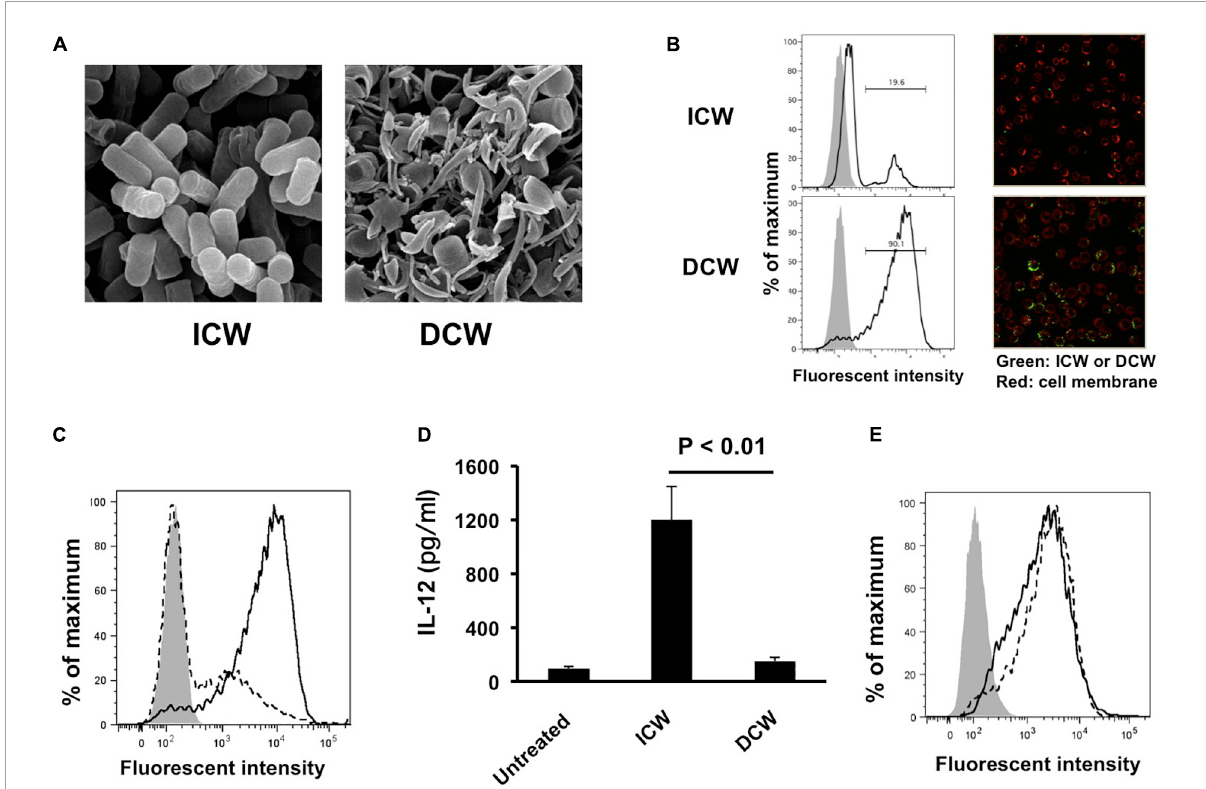
FIGURE9 Effects of disruption of overall shapes of ICWs on immunomodulatory abilities of ICWs. (A) Scanning electron microscopy of ICWs and DCWs of L. plantarum TUA 5099L. (B) Uptake of ICWs or DCWs. J774.1 cells were incubated with fluorescein-labeled ICWs or disrupted ICWs (DCWs) of L. plantarum TUA 5099 for 30 min and fluorescent signals in the cells were analyzed. Gray and open histograms indicate untreated and fluorescein-labeled cell walls treated cells, respectively. Representative images under florescent microscopy were also shown. (C) Reduction of uptake of DCWs by HF treatment. J774.1 cells were incubated with fluorescein-labeled DCWs (solid line) or HF-treated DCWs (dashed line) for 30 min and fluorescent signals in the cells were analyzed. Gray histograms indicate cells without DCW treatment. (D) Elicitation of IL-12 secretion from macrophages. J774.1 cells were cultured with ICWs (10 µ g/ml) or DCWs (100 µ g/ml) for 24 h and IL-12 secreted in culture supernatants was determined. Each bar is the mean ± SE for three independent experiments. (E) Effect of cytochalasin D on uptake of DCWs. J774.1 cells were treated with cytochalasin D in complete RPMI1640 containing 0.1% DMSO for 30 min at 37 ◦ C. Fluorescein-labeled DCWs were added and the mixture was incubated for 30 min. Fluorescent signals in the cells were analyzed. Solid and dashed lines indicate untreated and cytochalasin D-treated cells, respectively. Gray histograms indicate cells without DCW